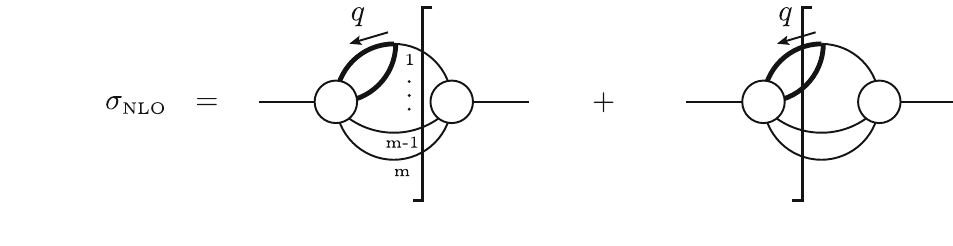
In this way, d σ ( r ) ( { s ij } ) is gauge invariant, since it is com- puted with massless kinematics and the fudge factor effectively replaces s ij → ¯ s ij in all relevant IR singular configurations. This is because d σ ( r ) ( { s ij } ) ∼ 1